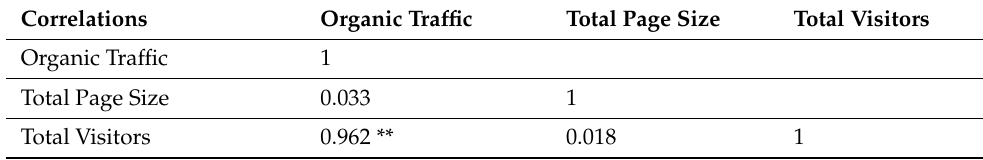
Table 3. Coefficients between the examined metrics for H1.